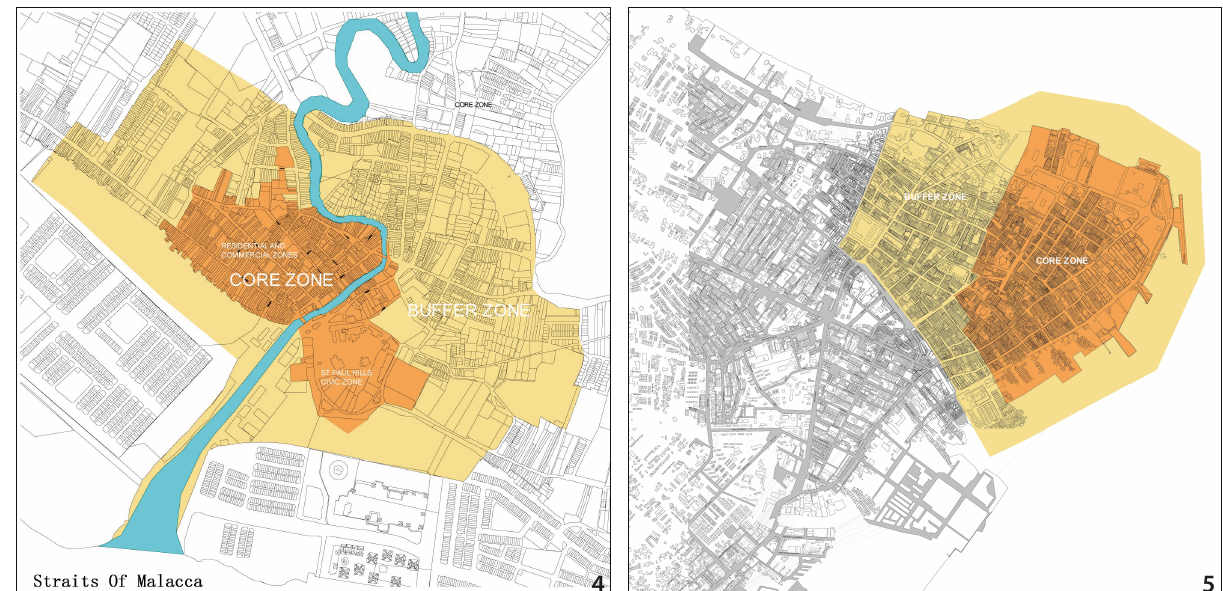
Figure 4 World Heritage Map of Malacca City: Core Zone and Buffer Zone (Source: the author). Figure 5 World Heritage Map of Penang City: Core Zone and Buffer Zone (Source: the